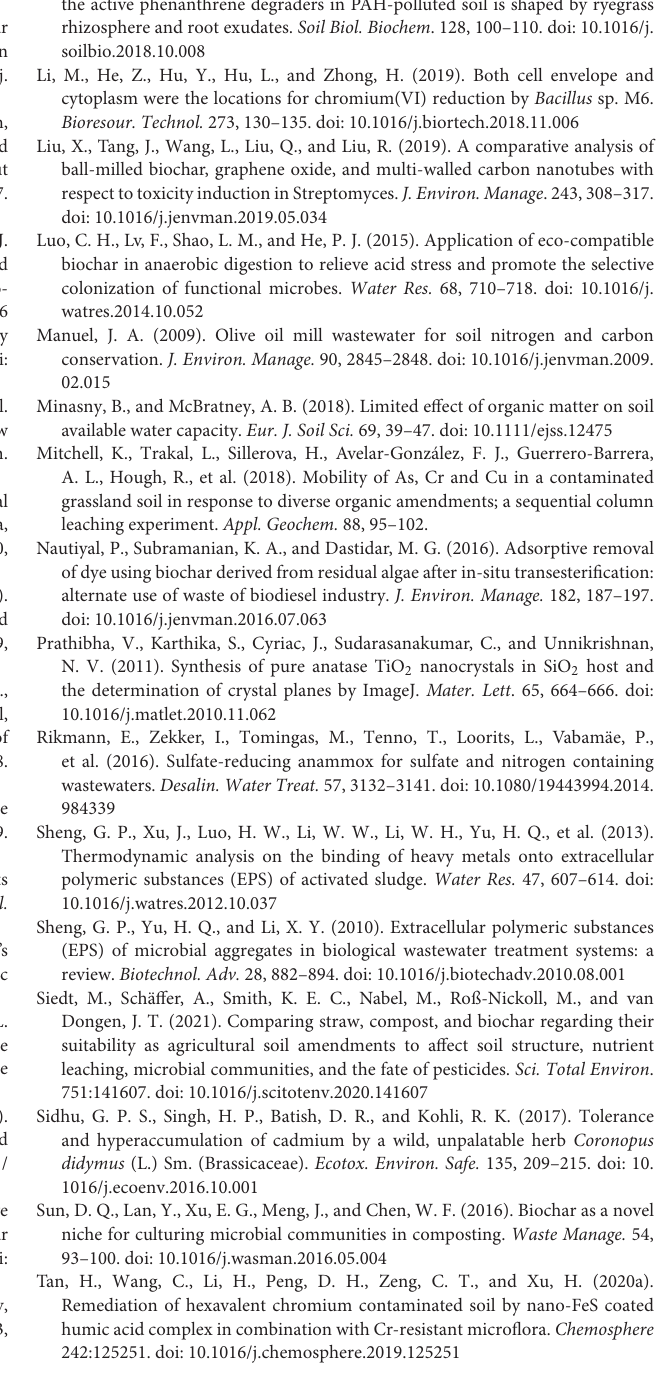
Supplementary Figure 3 | Cr content in Ryegrass with different remediation methods. Supplementary Figure 4 | Soil pH with different remediation